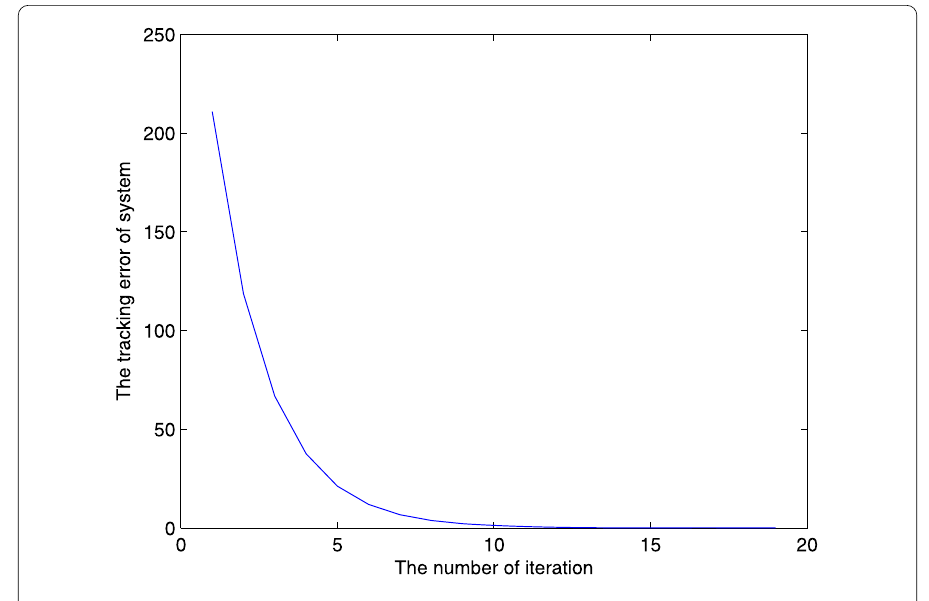
Figure 2 Number of iterations and tracking